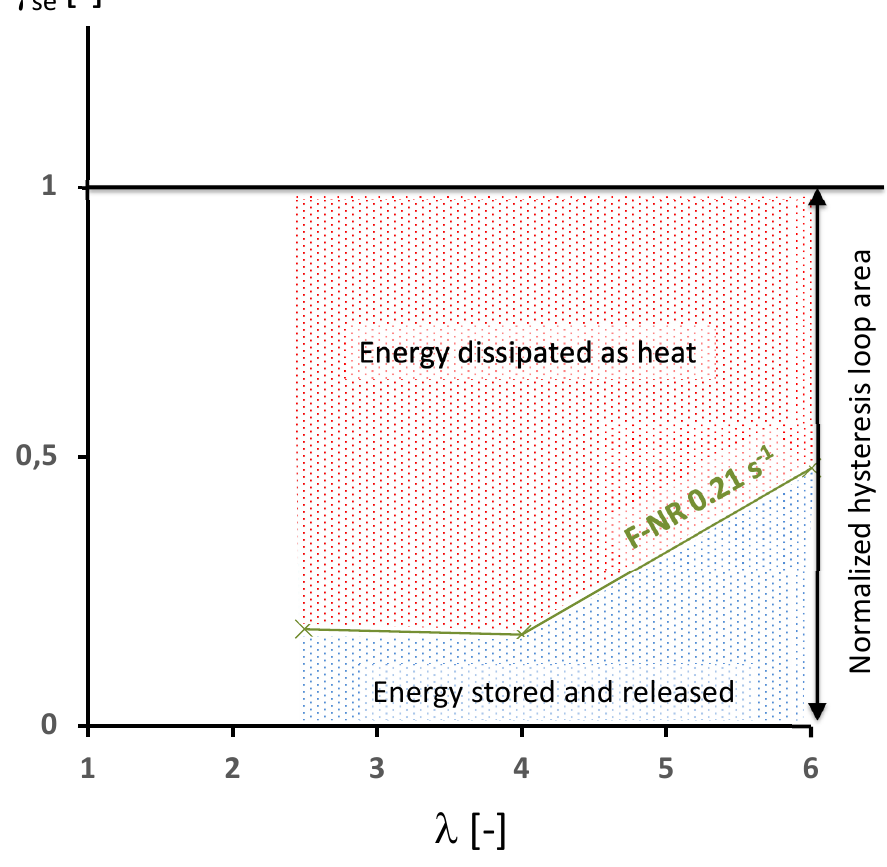
Figure 6. Energy characterization in terms of γ se versus stretch for the F-NR at 0.21 s − 1 .